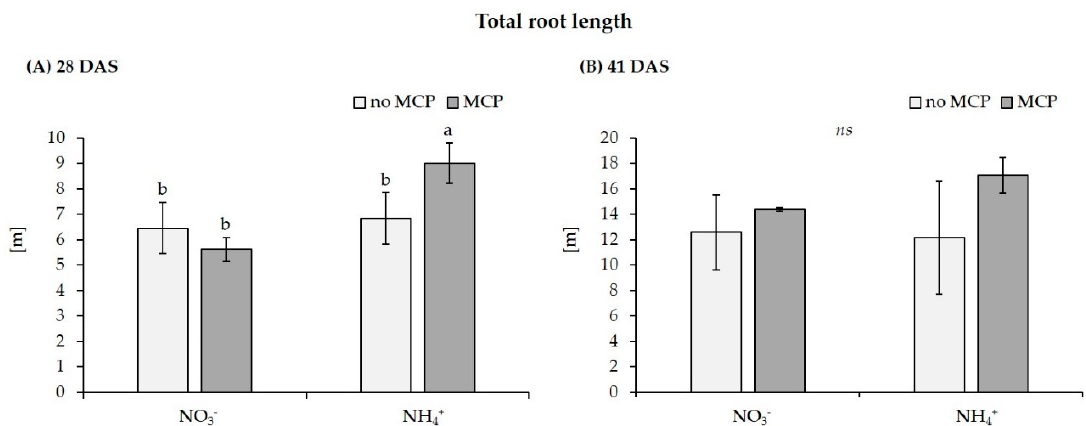
Figure 1. E ff ect of MCP inoculation on total root length of maize (cv Jessy) after a culture period of ( A ) 28 DAS and ( B ) 41 DAS on a clay-loam field soil (pH 5.9) with low P availability (Soil 2) supplied with moderate soluble P fertilization (30 mg P kg − 1 ) and N in form of Ca-nitrate (NO 3 − ) or DMPP-stabilized ammonium (NH 4 + ) Data represent means and SD of five replicates. A one-way ANOVA with Tukey test was performed. Di ff erent letters indicate significant di ff erences between treatments ( p < 0.05); ns = not significant.